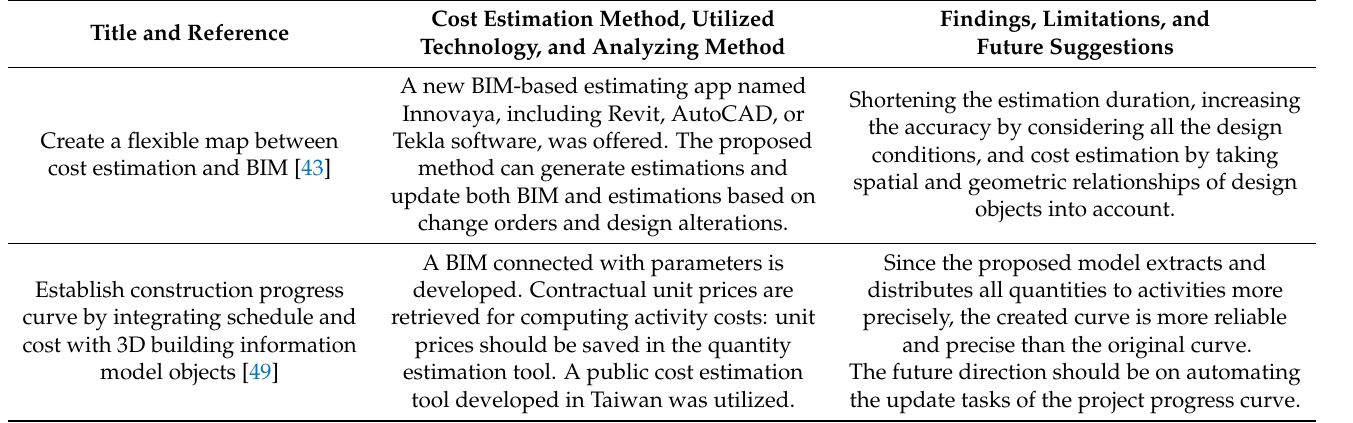
Table 3. Summary of papers focusing on BIM adoption for cost estimation and quantity surveying (Cluster